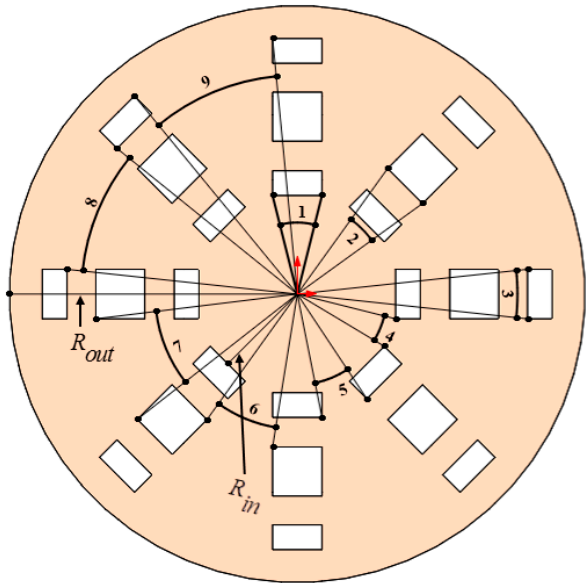
Figure 4. The cross-sectional view of rotor disk along with its dimensional parameters.